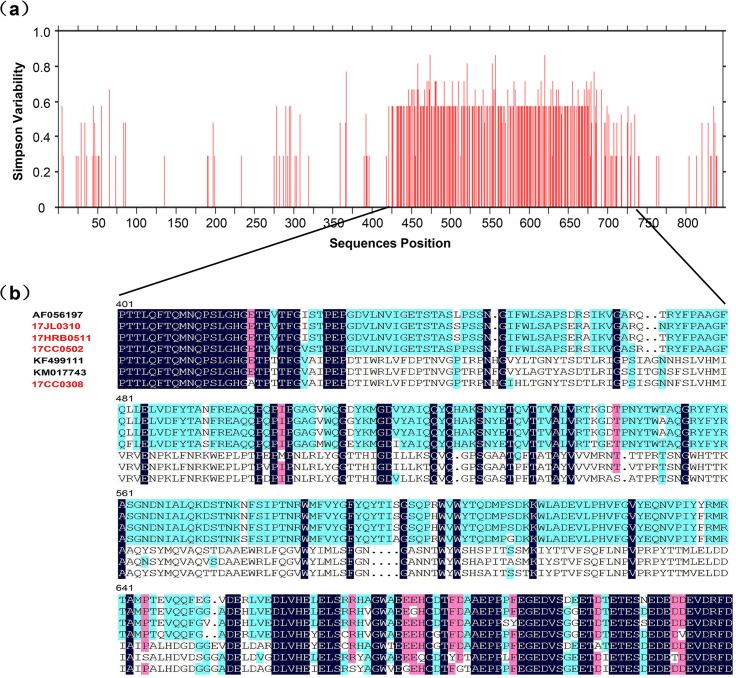
Variability analyses of capsid amino acid sequences among 20 FeAstV strains identified in this study and 5 FeAstV reference strains obtained from GenBank.(a) A variability scan for FeAstV capsid amino acid sequences was constructed using the Simpson diversity index in an online Protein Variability Server software (http://imed.med.ucm.es/PVS/). (b) Alignment of partial FeAstV capsid amino acid sequences (central region, from residues 401 to 720) between 4 representative strains identified in this study (red font) and 3 FeAstV reference strains.